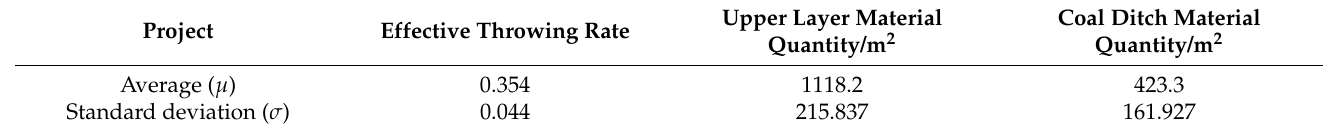
Table 4. Three basic indexes under the condition of 35 m blasting step height.